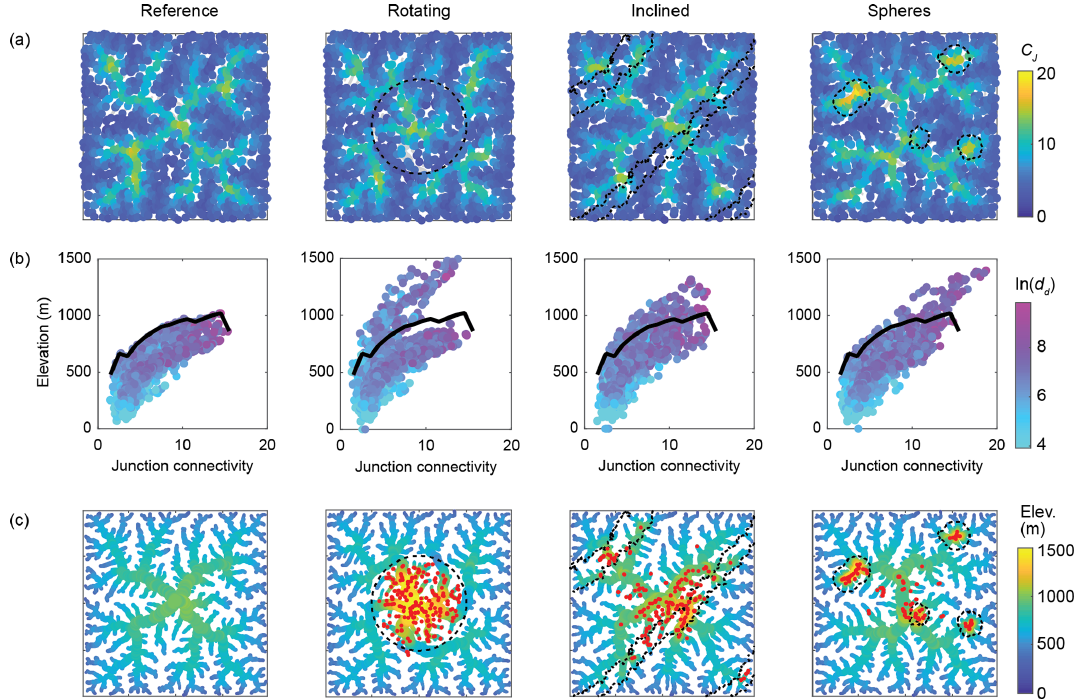
Figure 10. Divide junction connectivity ( C J ) from the final stage of the landscape evolution experiments Reference, Rotating, Inclined, and Spheres. C J was calculated with a d d , max value of 5000m. (a) Map view of divide junction C J values. Black dashed lines indicate perturbation elements in the models. (b) Scatter plot of C J by elevation, colored by the natural logarithm of the divide distance ( d d ). The thick black line follows the upper boundary of the divide junctions in the Reference model. (c) Drainage divide network colored by elevation. Red dots correspond to junctions in the perturbed models that lie higher than the junctions in the Reference